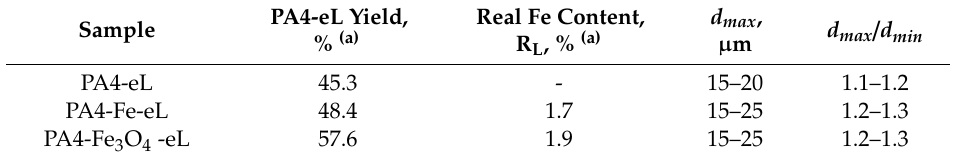
Table 4. Designation and some characteristics of PA4 supports with entrapped laccase (PA4@eL).